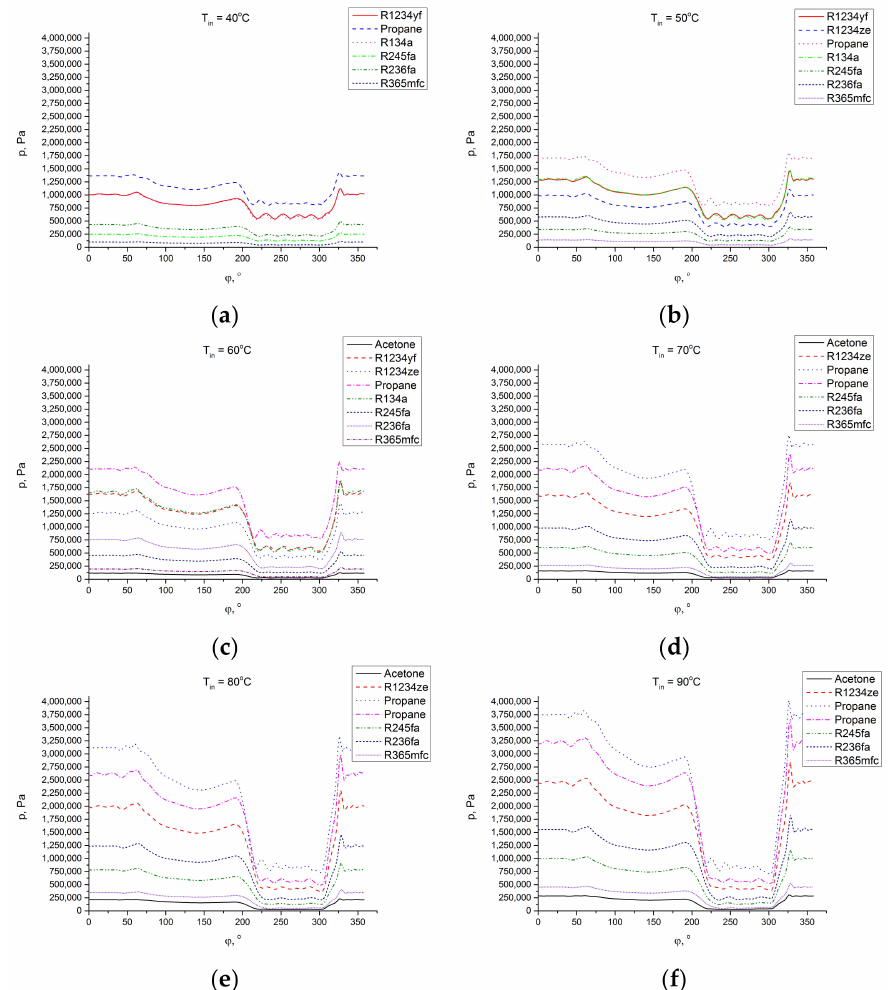
Figure 3. Pressure distribution against crank angle for different working fluids and inlet temperatures: